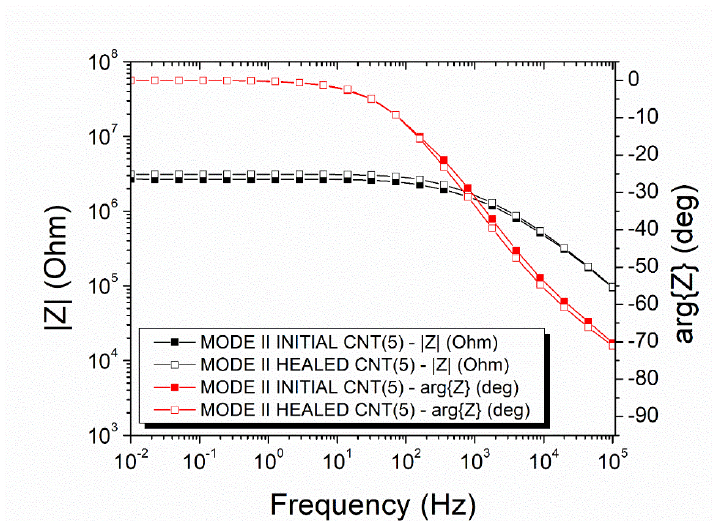
Figure 8. Representative Impedance plots of a mode-II specimen with nano-enhanced